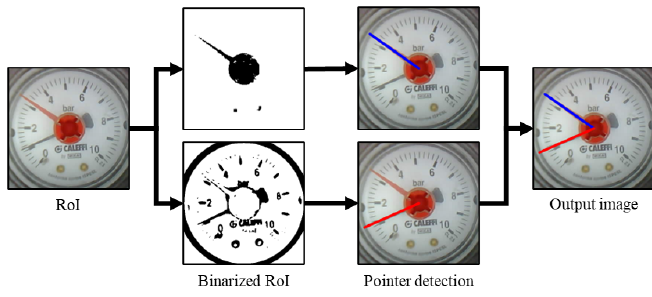
Figure 13. Flowchart of the pointer detection implementation.